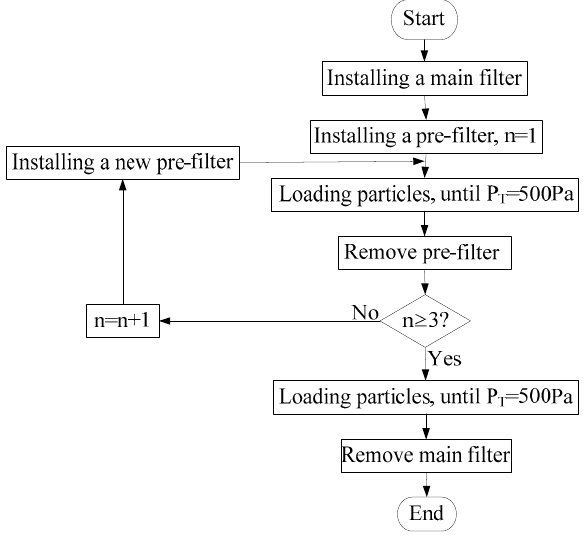
Figure 5. Diagram of the two-stage filtration tests